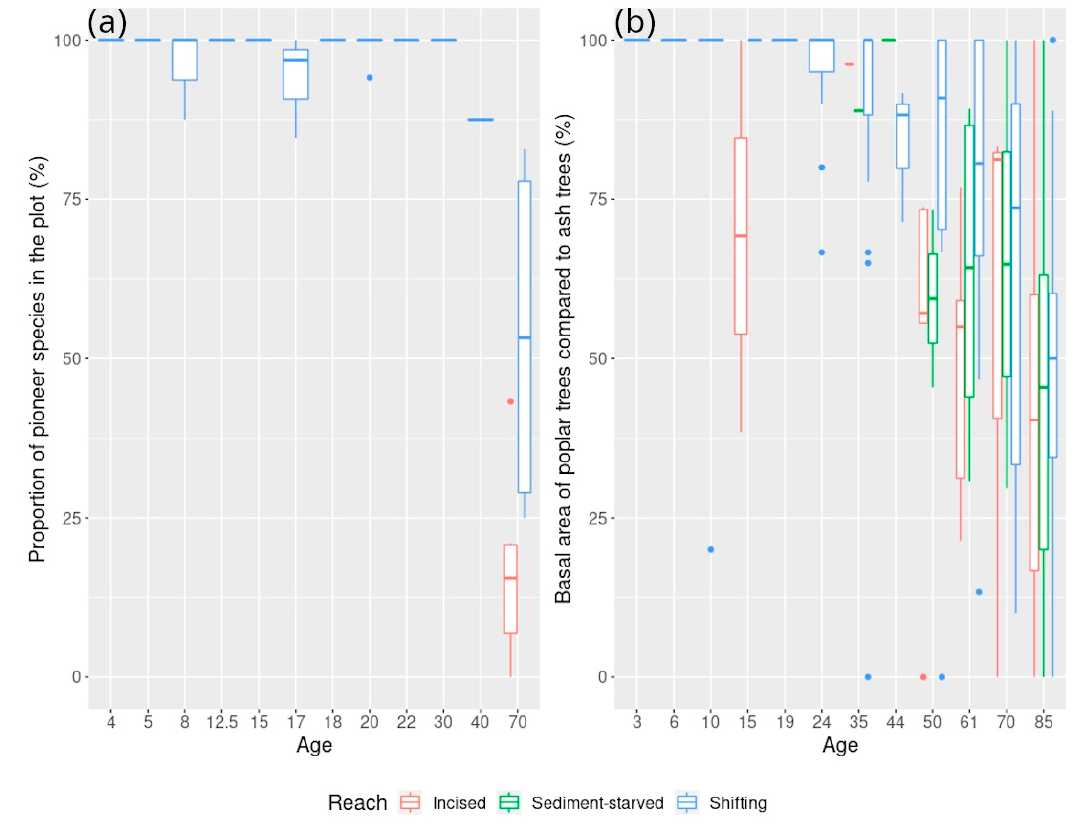
Figure 7. Percentage of pioneer species in vegetation plots according to plot age in the EVS survey ( a ) and the area of poplar trees in proportion to post-pioneer ash trees according to plot age in the ONF survey ( b ). Table 5. Example species distributions from the vegetation survey conducted by the EVS laboratory along the vertical gradient (70 y.o.) for plots in both the shifting reach and incised